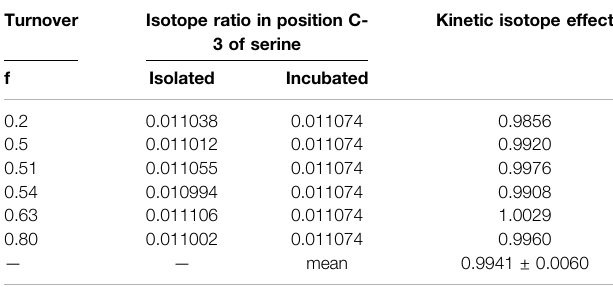
TABLE 2 | Isotope ratio of position C-3 in serine before and after incubation with SHMT and calculated kinetic isotope effect on the reaction. Turnover Isotope ratio in position C- 3 of serine